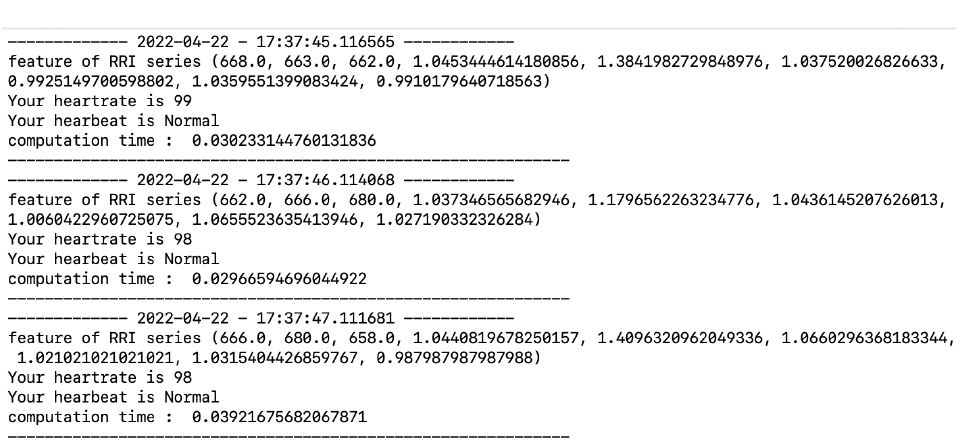
Figure 3. Class diagram of real-time monitoring system.